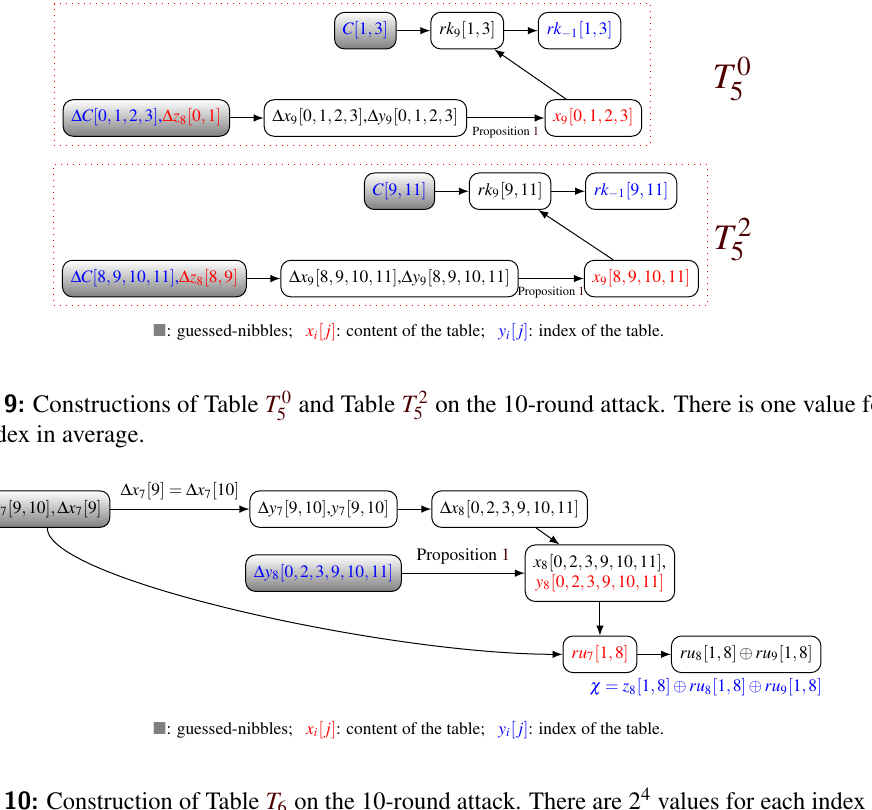
Figure 10: Construction of Table T 6 on the 10-round attack. There are 2 4 values for each index in